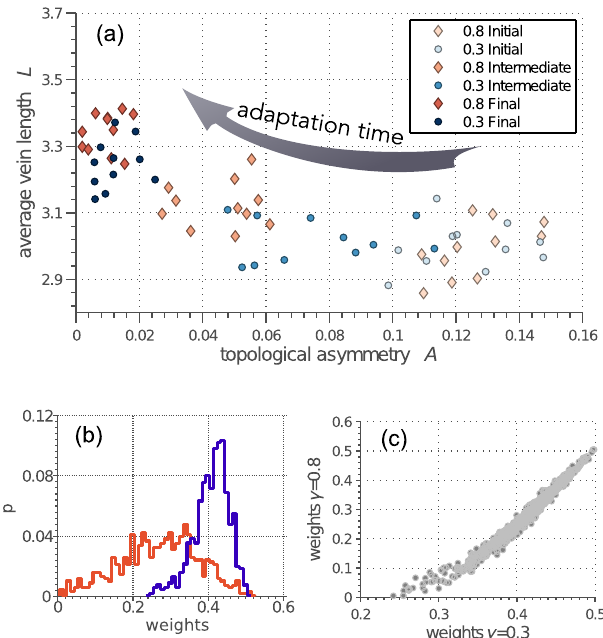
FIG. 14. (a) Average vein length L versus topological asym- metry A for initial, intermediate, and final states of an initially random-weighted network evolving under our adaptive model. (b) Distribution of the edge weights in the final adapted states for two different sigmoidal-feedback control exponents, γ . (c) Struc- tural correlations in the adapted weights from identical starting configurations for two different sigmoidal-feedback control exponents, γ